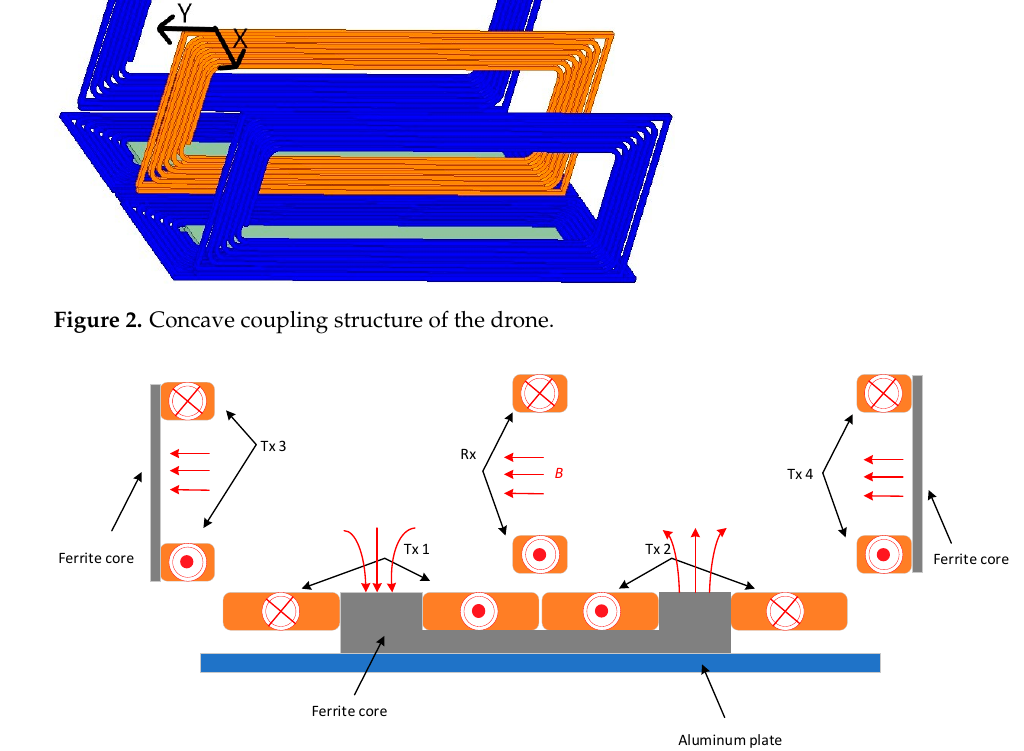
Figure 3. Magnetic field distribution of the coupled structure.